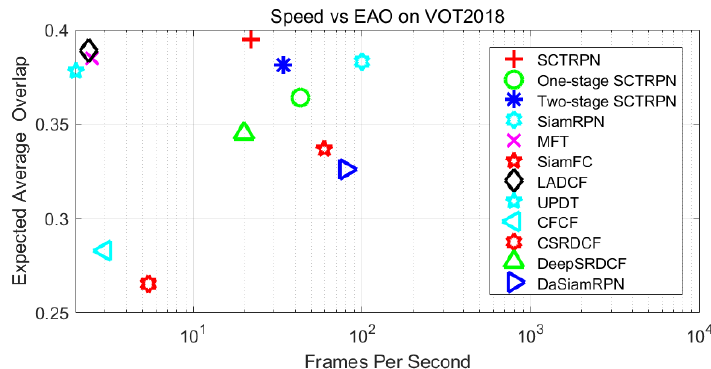
Figure 8. A comparison of the quality and the speed of state-of-the-art tracking methods on VOT2018. The expected average overlap (EAO) with respect to the frames-per-second (FPS) are visualized in the Figure. Note that the FPS axis is in the log scale.